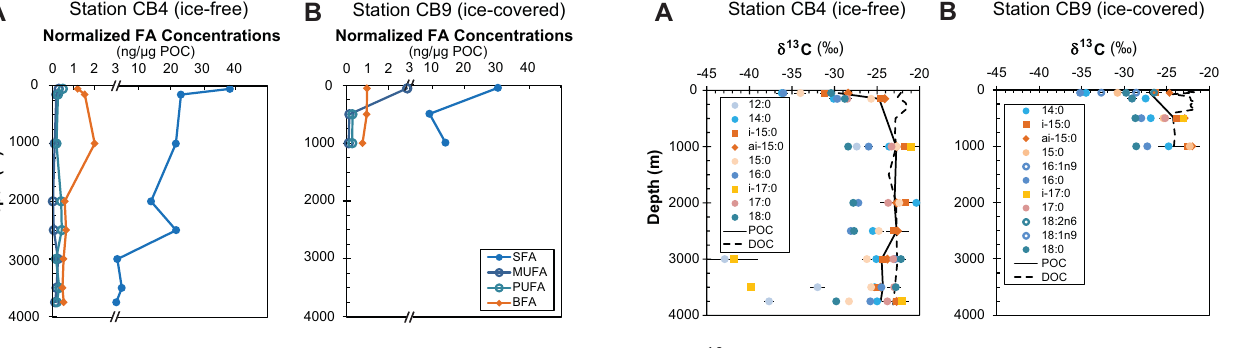
Fig. 3. POC-normalized concentrations of fatty acids grouped into saturated (SFA), branched (BFA), monounsaturated (MUFA) and polyunsaturated (PUFA) and plotted with depth at (a) Station CB4 and (b) Station CB9.